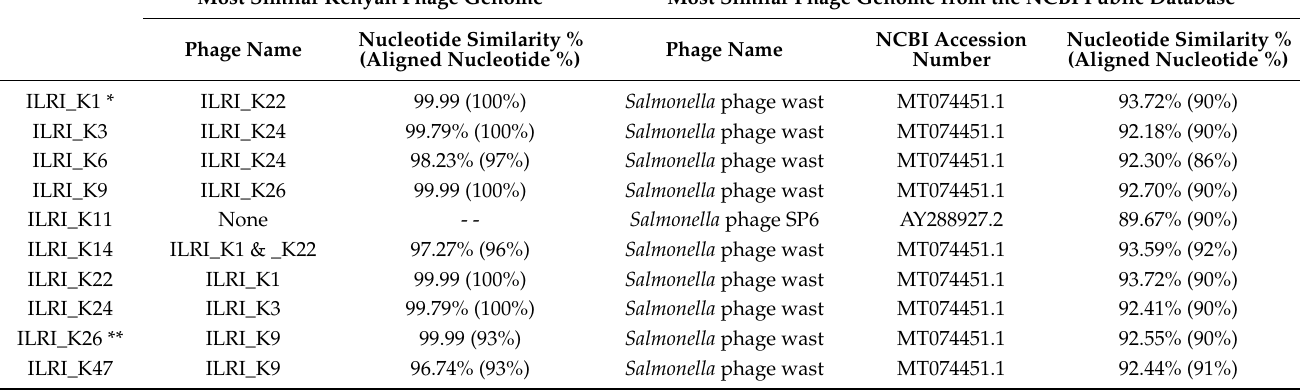
Table 3. Nucleotide similarities between Kenyan phage genomes and published phage genomes from the NCBI public